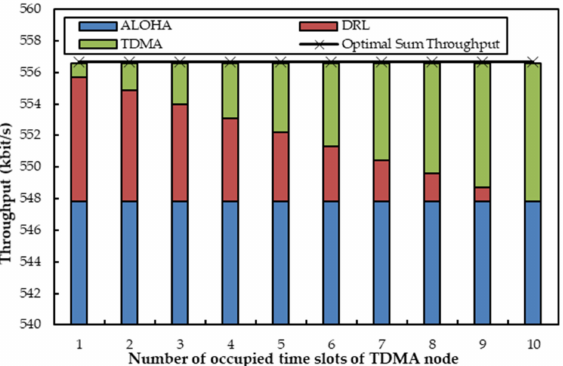
Figure 6. Sum throughput when one agent coexists with one optical ALOHA node and one acoustic TDMA node, which have fixed q and variable R .